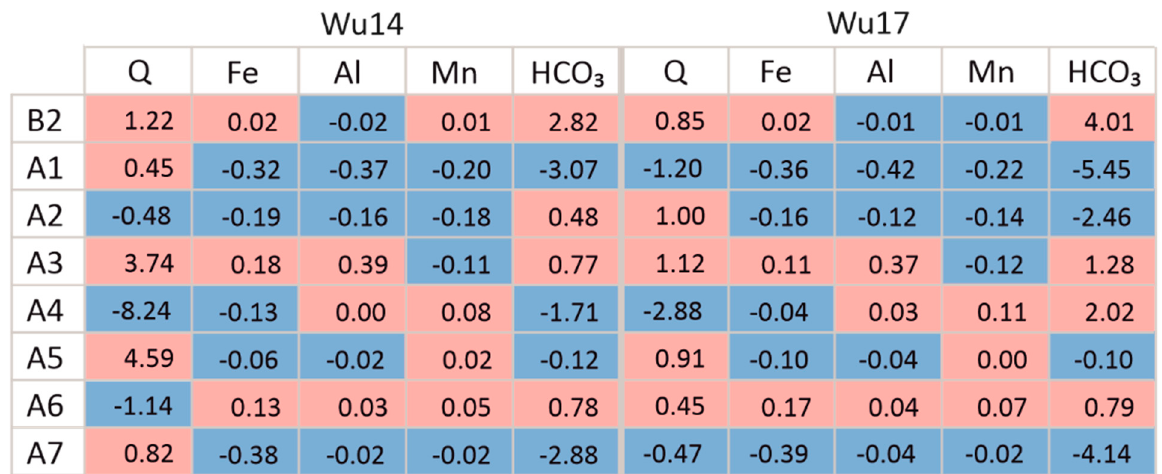
Figure 9. Changes in annual discharge (Q; l s − 1 ) and chosen ions net stream outputs (t km − 2 a − 1 ) compared to the previous year in the partially deforested Wüstebach catchment (Wu14) and the control catchment (Wu17): B2—second year before deforestation (2012/13), A1–A7—seven years after deforestation (2013/14–2019/20). Red—increase (>0 t km − 2 a − 1 ), blue—decrease (<0 t km − 2 a − 1 ).